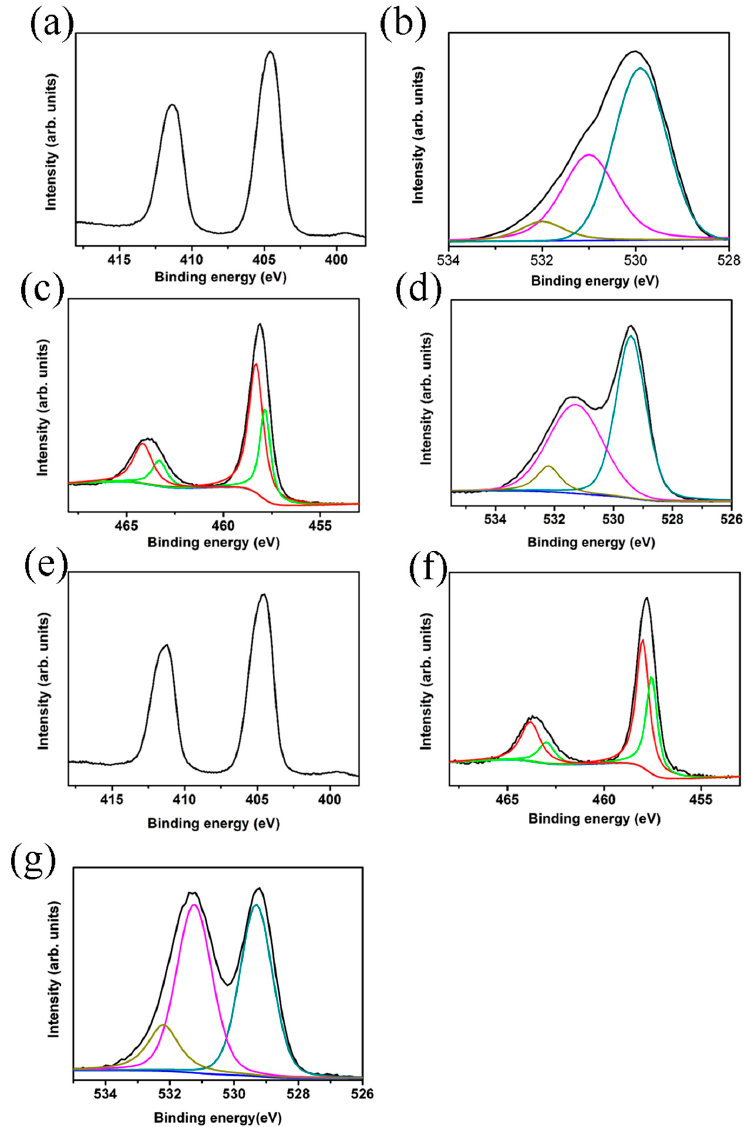
Figure 5. XPS narrow scan analyses for the CdO thin film, TiO 2 rods, and TiO 2 –CdO composite rods: ( a ) Cd 3d core-level doublet peaks of the CdO thin film; ( b ) O1s core-level spectrum of the CdO thin film; ( c ) Ti 2p core-level spectra of the TiO 2 rods; ( d ) O1s core-level spectrum of the TiO 2 rods; ( e ) Cd 3d core-level doublet peaks of the TiO 2 –CdO composite rods; ( f ) Ti 2p core-level spectra of the TiO 2